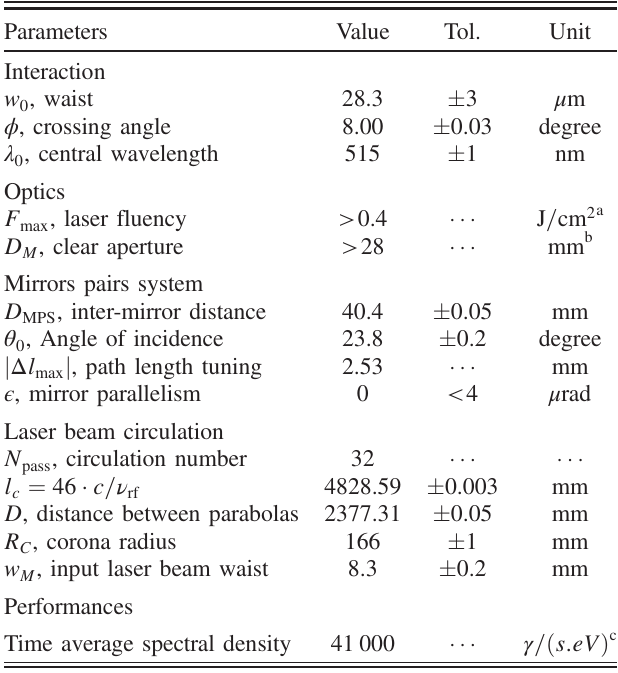
TABLE I. Summary of the optimized parameters to reach ELI- NP-GBS specifications, using design electron beam parameters [10]. The reader is referred to Ref. [29] for a detailed description of the meaning of the parameters.